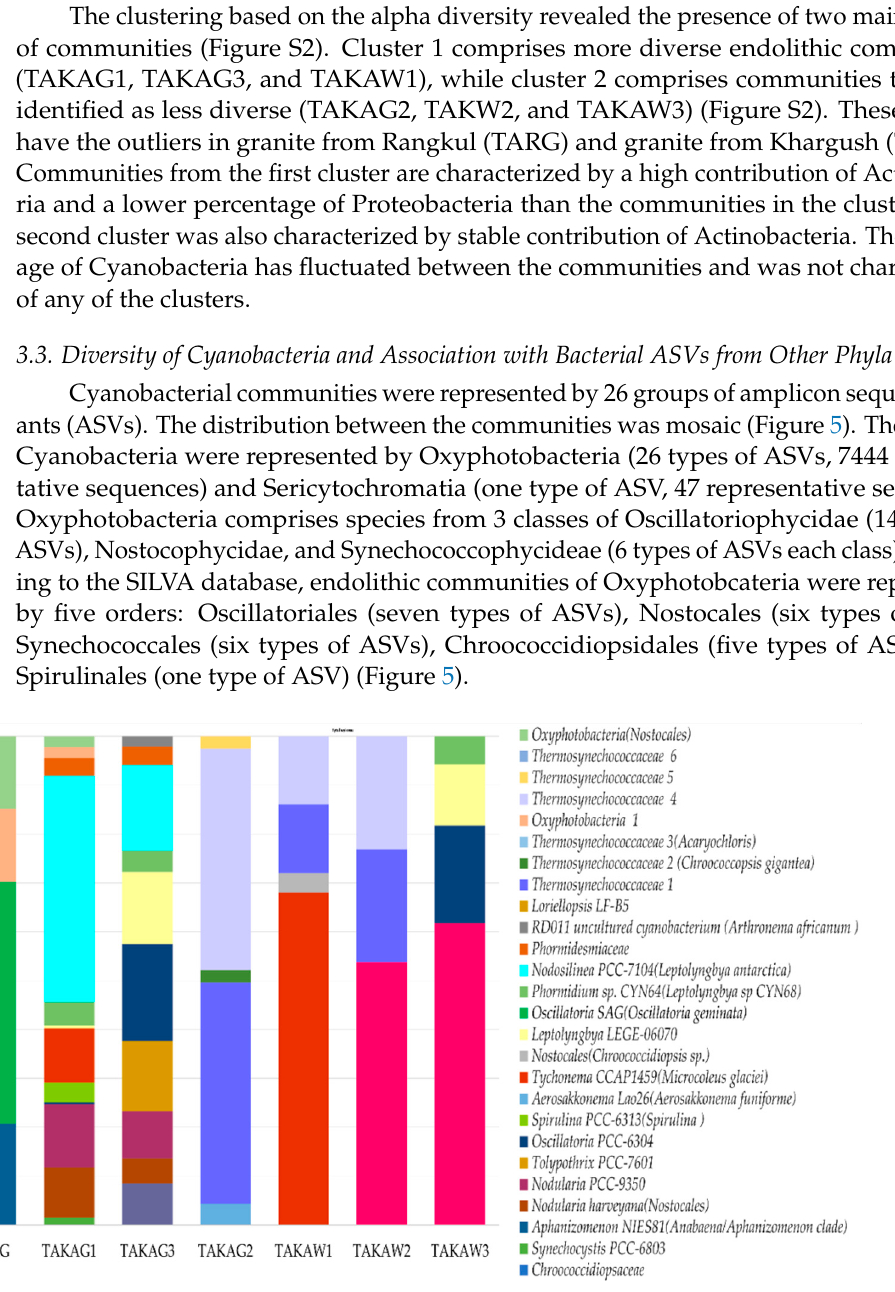
Figure 5. The V3–V4-based structure of endolithic cyanobacterial communities based on ASVs. The names of ASVs obtained using the phylogenetic placement method are given in brackets.